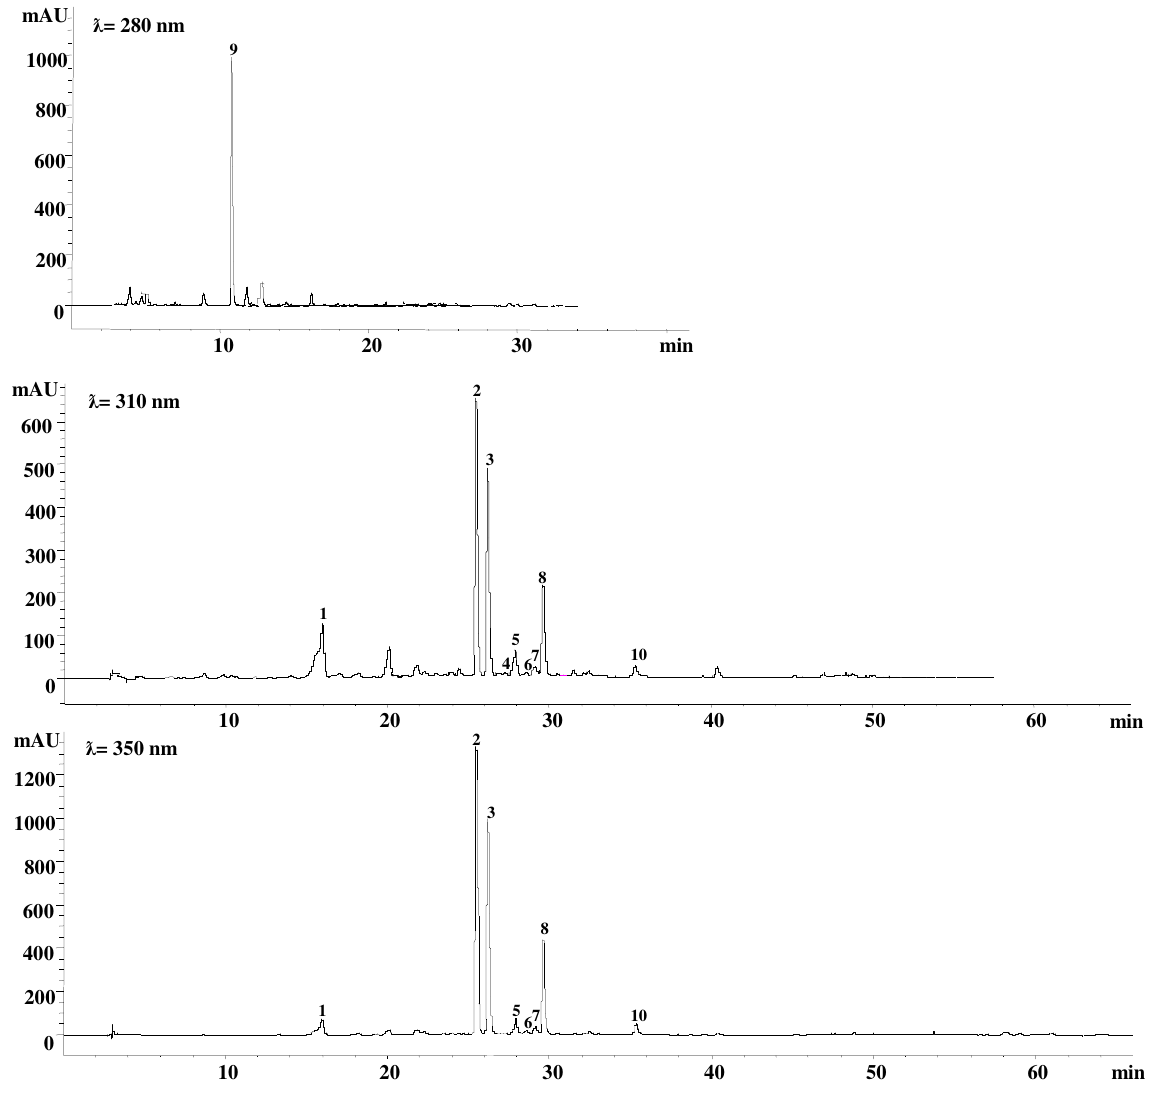
Figure 1. HPLC/DAD chromatograms at different wavelengths of leaf globe artichoke extracts: 5- O - caffeoylquinic acid (1); luteolin-7- O -glucoside (2); luteolin-7- O -glucuronide (3); 3,5- O -dicaffeoylquinic acid (4); 1,5- O -dicaffeoylquinic acid (5); apigenn-7- O -rutinoside (6); apigenn-7- O -glucoside (7); luteolin malonylglucoside (8); cynaropicrin (9); luteolin (10).